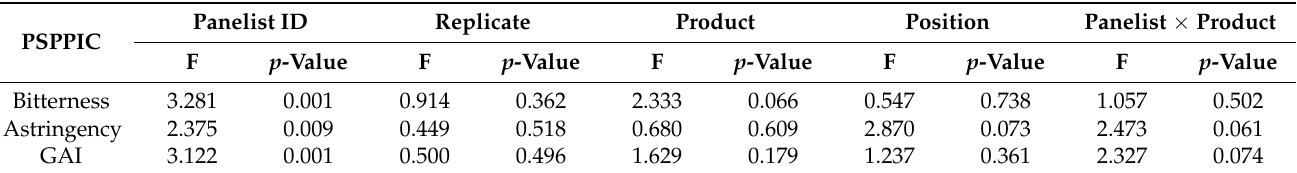
Table 4. Results of three-way ANOVA for PSPPIC samples (PSPPIC10, PSPPIC15, PSPPIC20, PSP-